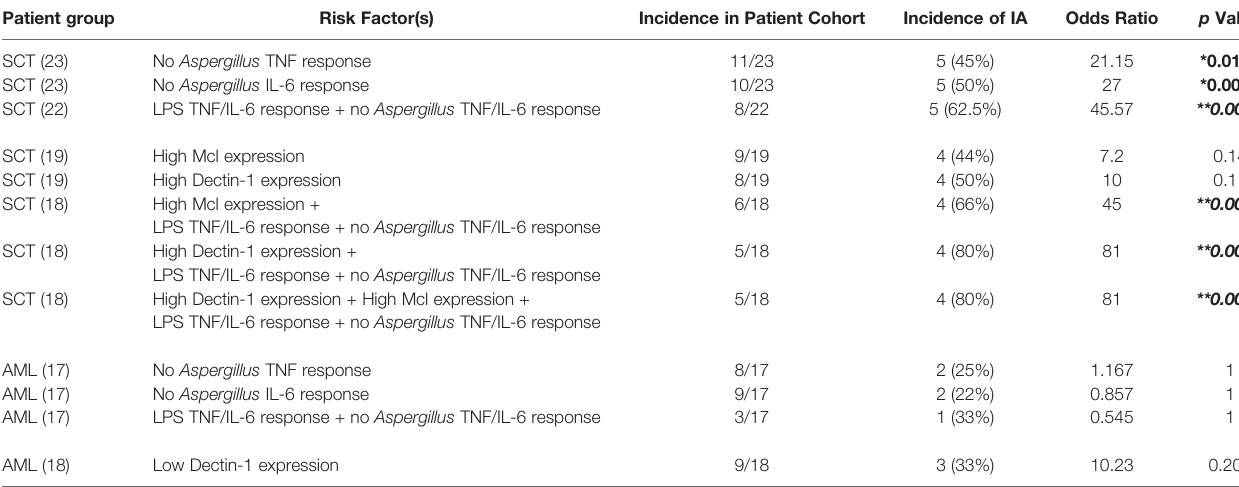
TABLE 4 | SCT patients can be strati fi ed according to IA risk using their CLR status and functional immune response results. Patient